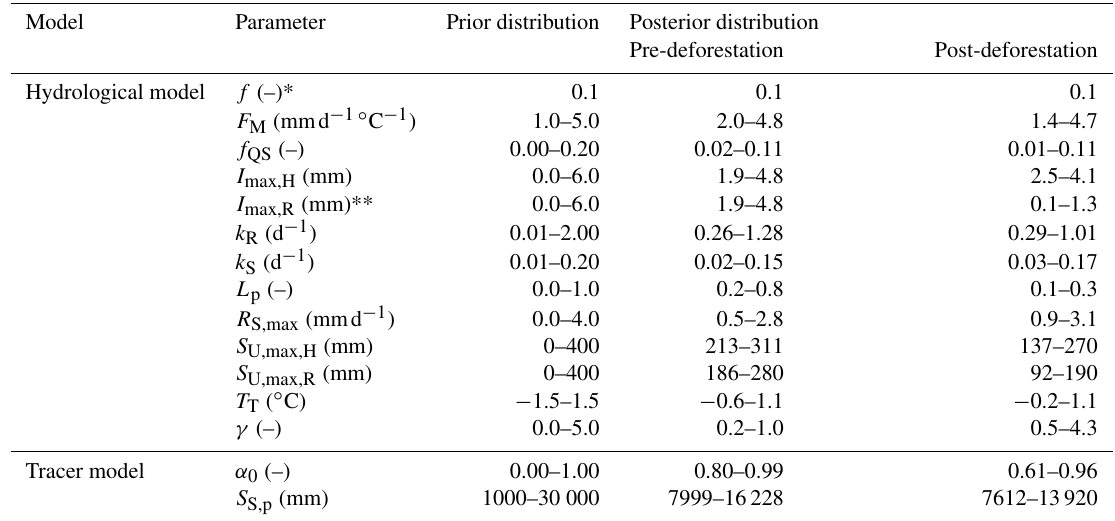
Table 2. Parameter prior distributions and 5th / 95th percentiles of the posterior distributions. Note that * parameter f , characterizing the areal proportion of the riparian zone, was fixed according to soil and elevation data and ** the interception capacity I max was assumed to be identical on the hillslopes and the riparian zone in the pre-deforestation period.